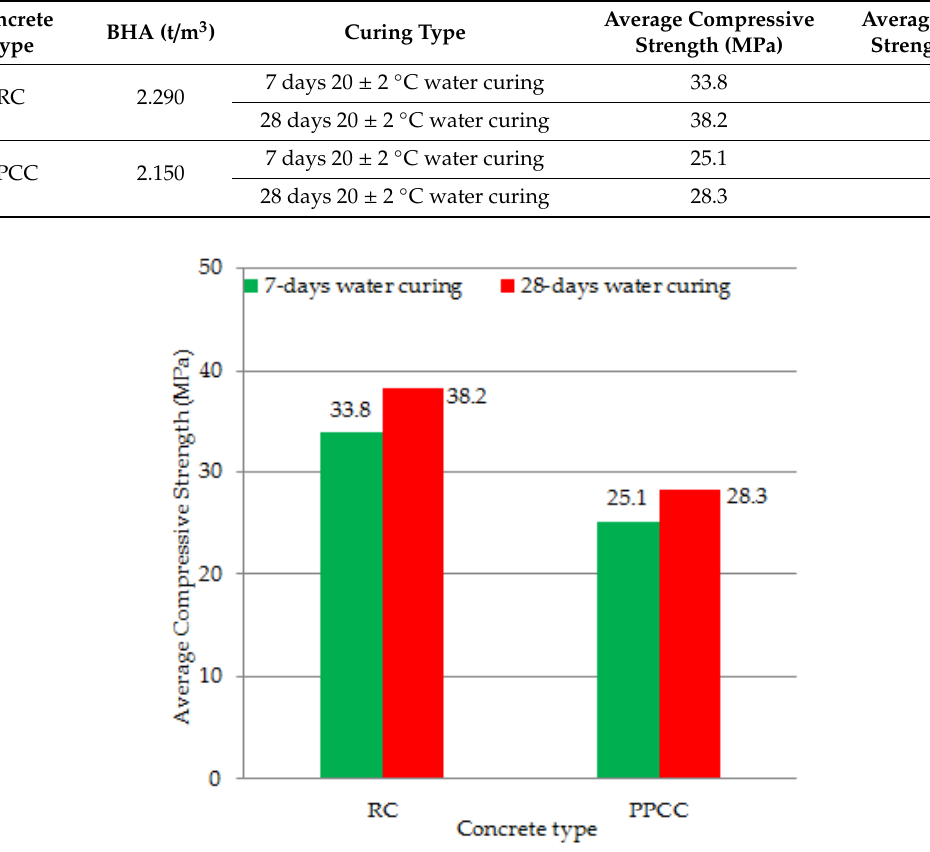
Figure 13. The average compressive strength results of RC and PPCC concrete.